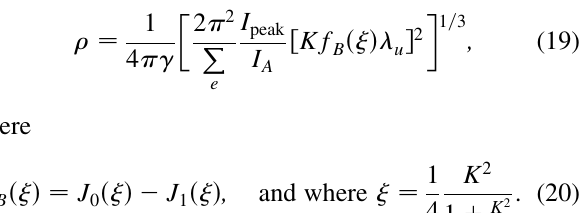
the change in the relative E